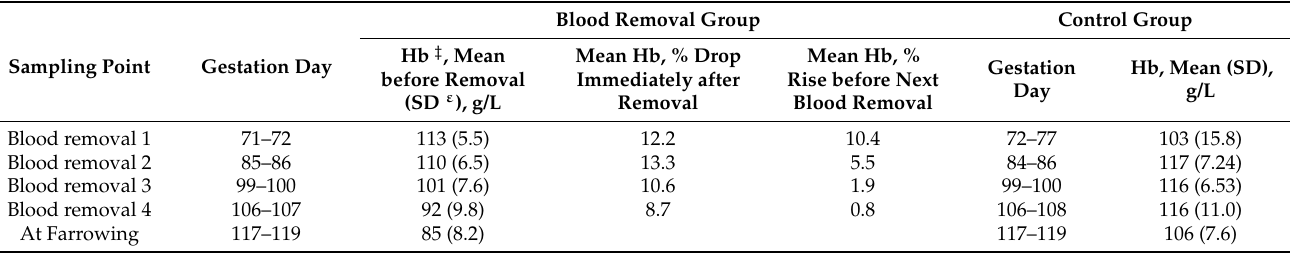
Figure 2. Blood hemoglobin (Hb) development during the experiment for the control group in trial I. Development in blood Hb levels during gestation in control sows fed a gestation diet with an iron supplement. The Hb levels of four sows were monitored from gestation day 72–77 until farrowing. The regression lines indicate relatively uniform progressions in Hb levels with the slopes not significantly different from zero. Table 1. Hemoglobin levels on blood removal days and at farrowing in trial